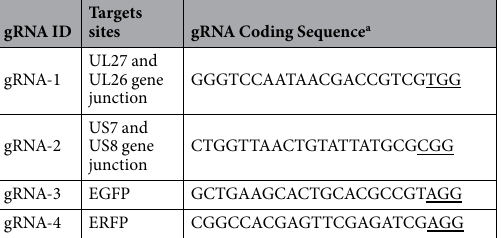
Table 1. The gRNA coding sequences and targets sites. a Underlined text shows the protospacer adjacent motif (PAM) sequence located on the immediate 3 ′ termination of the gRNA recognition